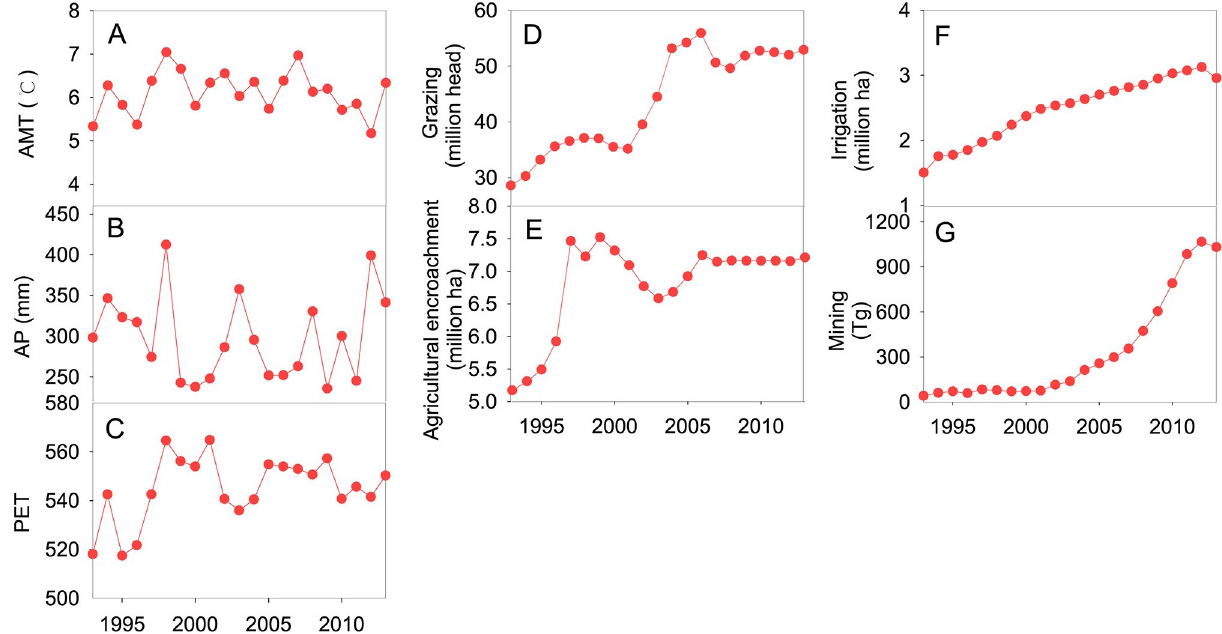
Fig 3. Changes of climate and human activities in Inner Mongolia during1993-2013. (A) AMT (annual mean temperature), (B) AP (annual precipitation), (C) PET (potential evapotranspiration), (D) Grazing intensity characterized by number of goats and sheep, (E) Agricultural encroachment indicated by area of cultivated lands, (F) Agricultural irrigation expressed by area of effective irrigation, (G) Mining indicated by coal production.